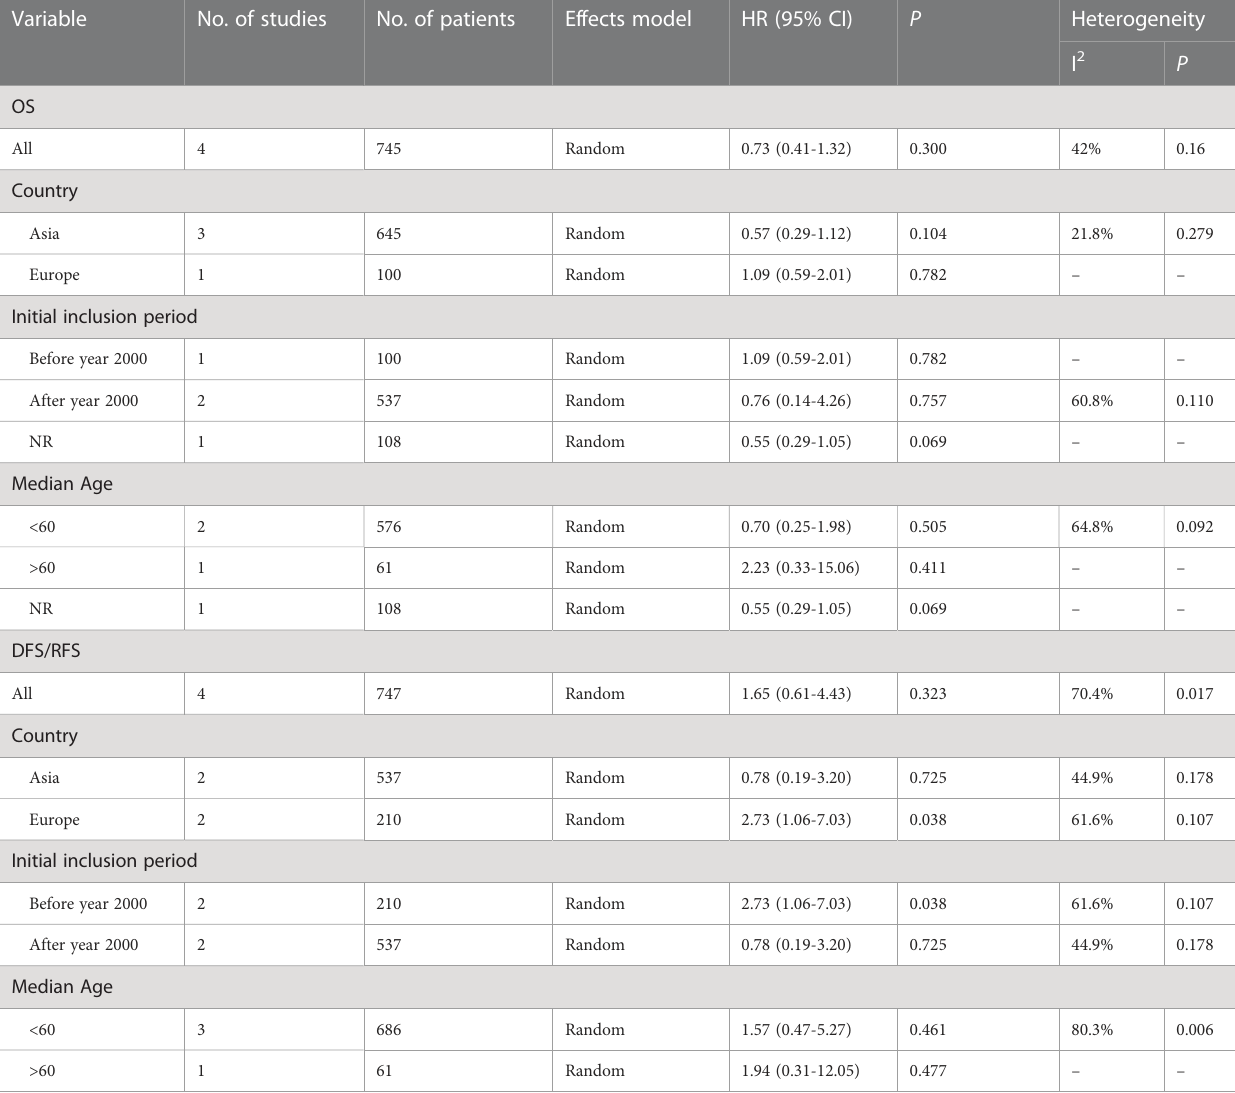
TABLE 2 Subgroup analyses of OS, DFS/RFS in breast